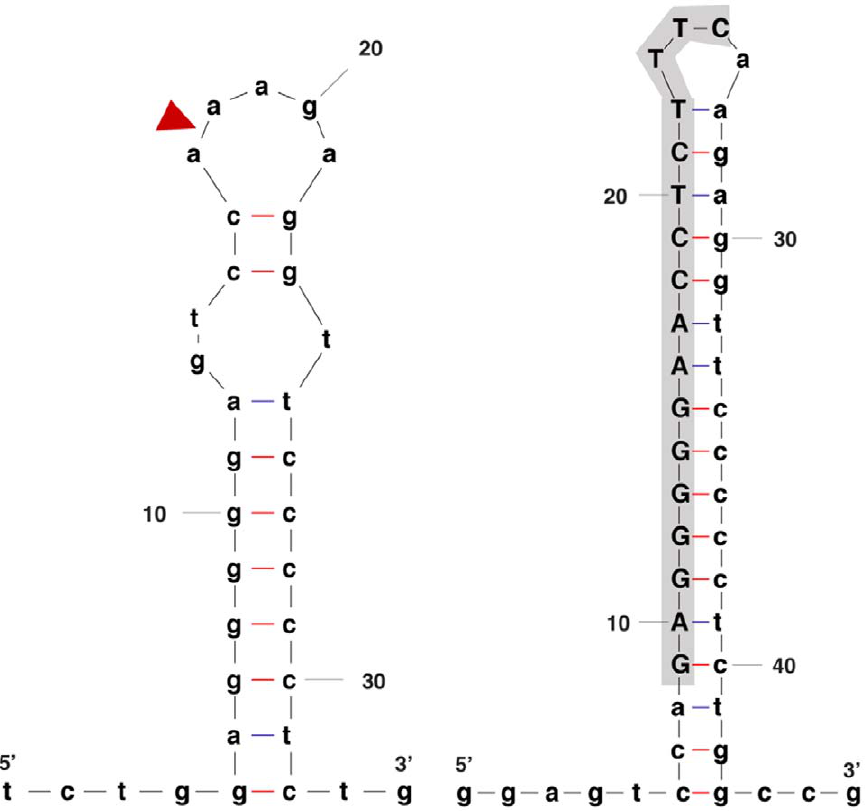
Figure 1. Example of the increase in secondary structure following determination of the gap sequences: Gap 1. Left- secondary structure prediction done using the Mfold web server [29] to aid in primer site selection. Closed triangle shows the location of the gap. Structure was prepared by appending 100 nt at the termini of the 5 9 and 3 9 contigs surrounding the gap. Folding parameters used 50 mM NaCl, and 2.5 mM MgCl 2 at 60 u C. Excess nucleotides were trimmed from the structure for presentation. Right – secondary structure including the determined gap sequence. The determined gap sequence nucleotides are highlighted in upper case. Folding parameters are as given for the structure prepared prior to gap sequence